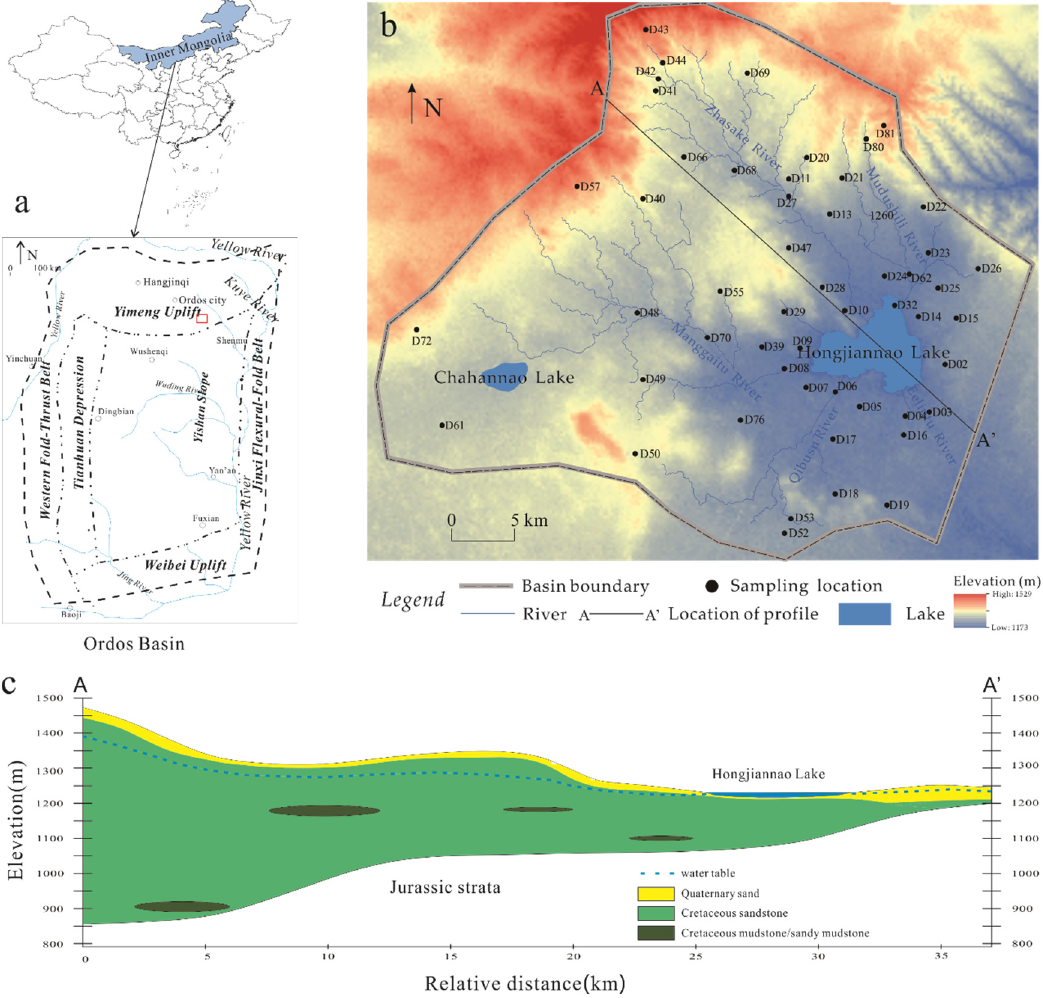
Figure 1. Location and hydrogeological condition of the study area and sampling locations (( a ). Tectonic geology sketch of Ordos Basin ( b ). Sampling locations ( c ). Hydrogeological profile of A–A ′ .)